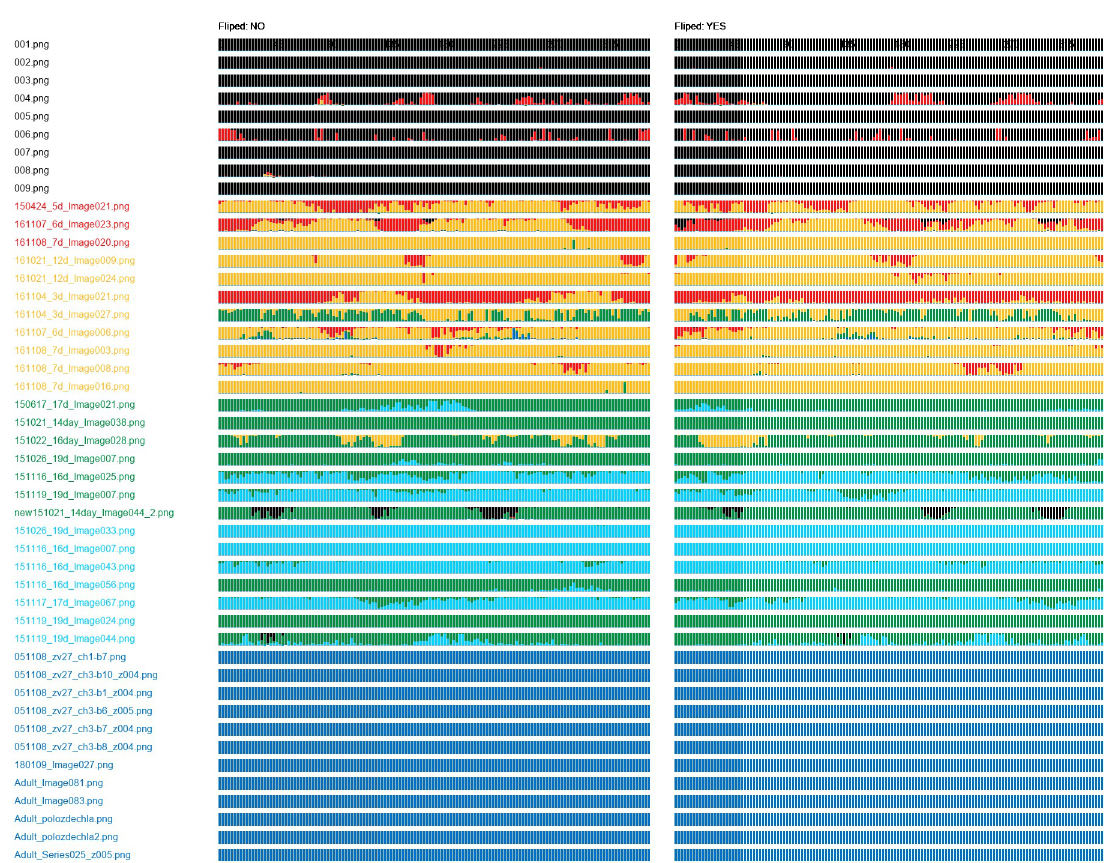
Fig 10. Class probability graph obtained for the DenseNet-1024 trained on T-1024-B. The trained network perfectly recognizes samples of the class 5. It does also very well on samples of the class 0. Some samples of other categories are incorrectly classifieds, but they are mostly assigned into neighbour